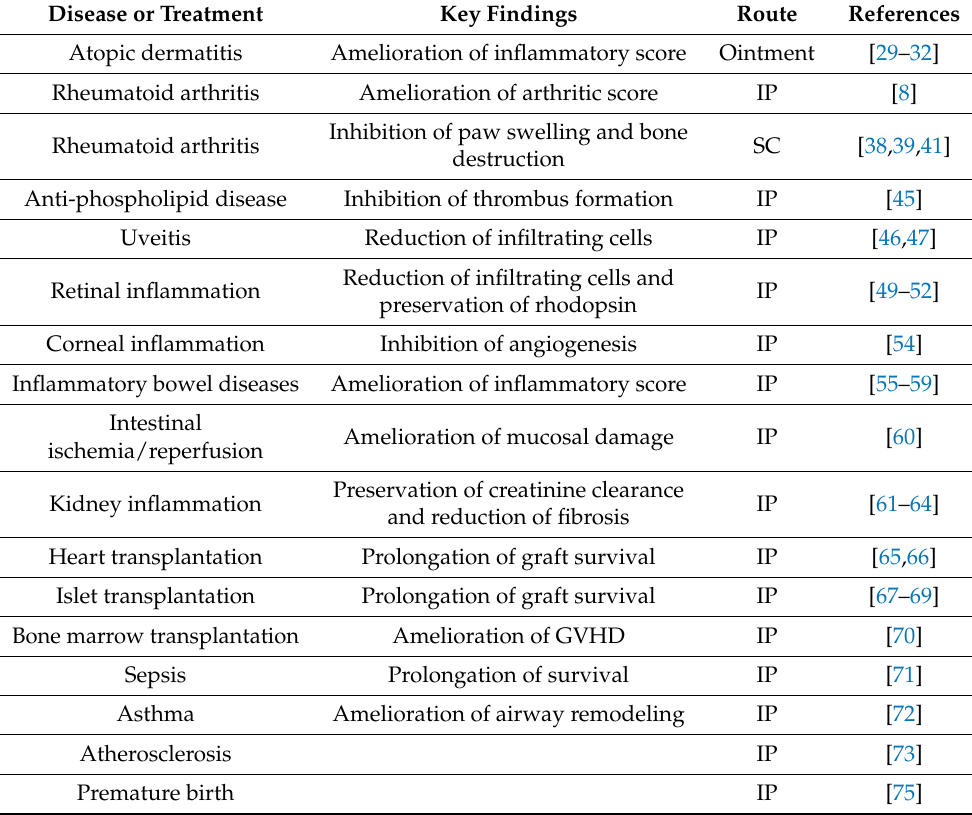
Table 1. Anti-inflammatory activity on in vivo disease models. Disease or